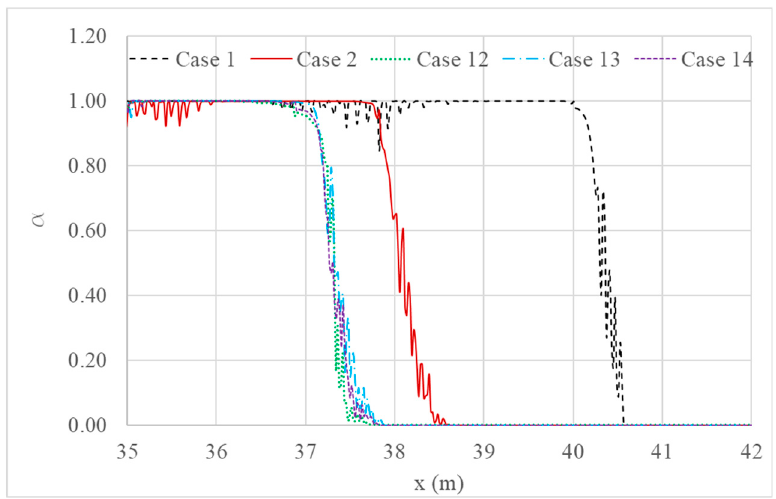
Figure 20. Comparison of wave run-up for each simulation case with different trench depths.